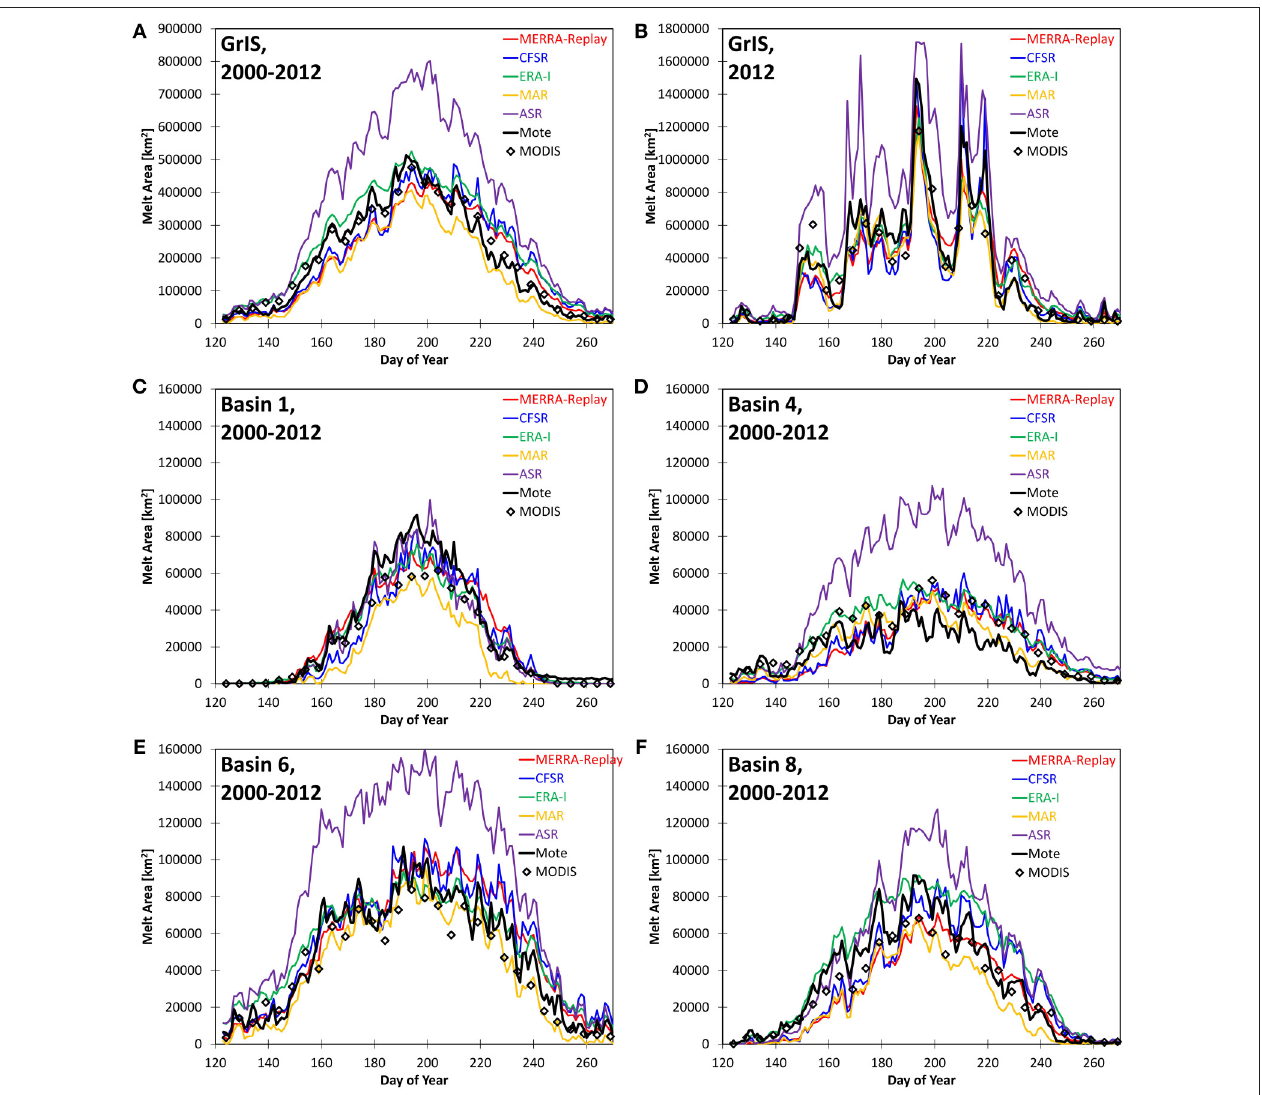
FIGURE 7 | Annual time series of melt area from five data sets in comparison to passive microwave (solid black line) and MODIS 5-day averages (diamonds) for (A) the total GrIS, averaged for 2000-2012; (B) the total GrIS for the year 2012; and (C) drainage basin 1, (D) basin 4, (E) basin 6, and (F) basin 8 averaged for 2000-2012, in km 2